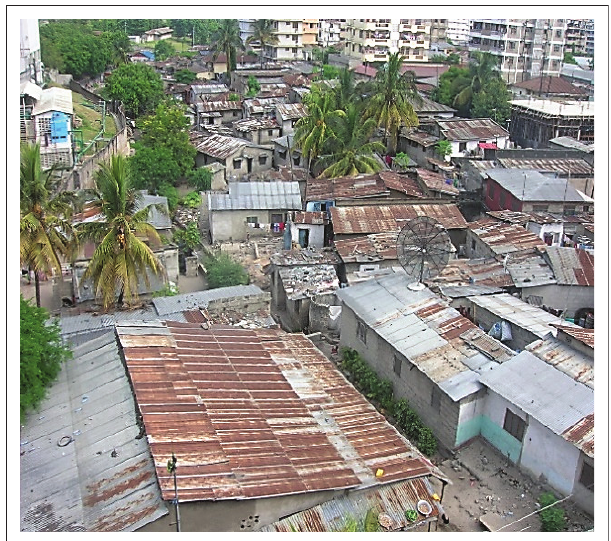
FIGURE 1: Aerial view of Mchikichini